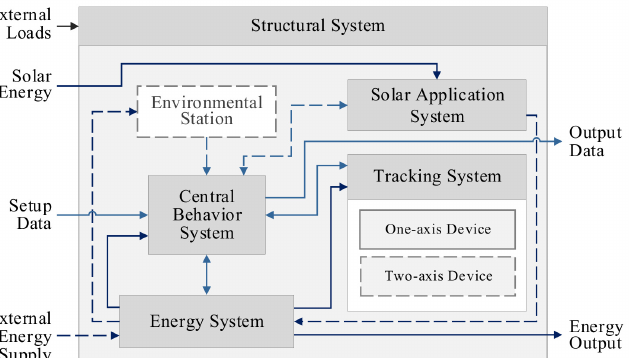
Figure 1. Proposed generic physical architecture of Solar Tracking Systems, the dotted lines represent the possibility that the systems and inputs-outputs exist, according to the design